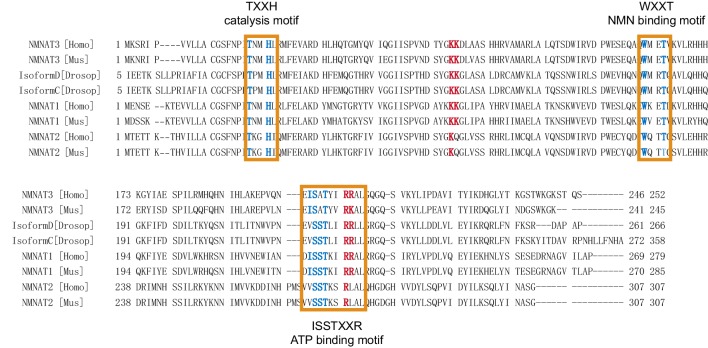
Sequence alignment of NMNATs from different species.The catalytic and substrate-binding motifs (highlighted with orange frames) are highly conserved and the conserved residues are in blue. The positively charged residues that are essential for the chaperone-like activity are colored in red.